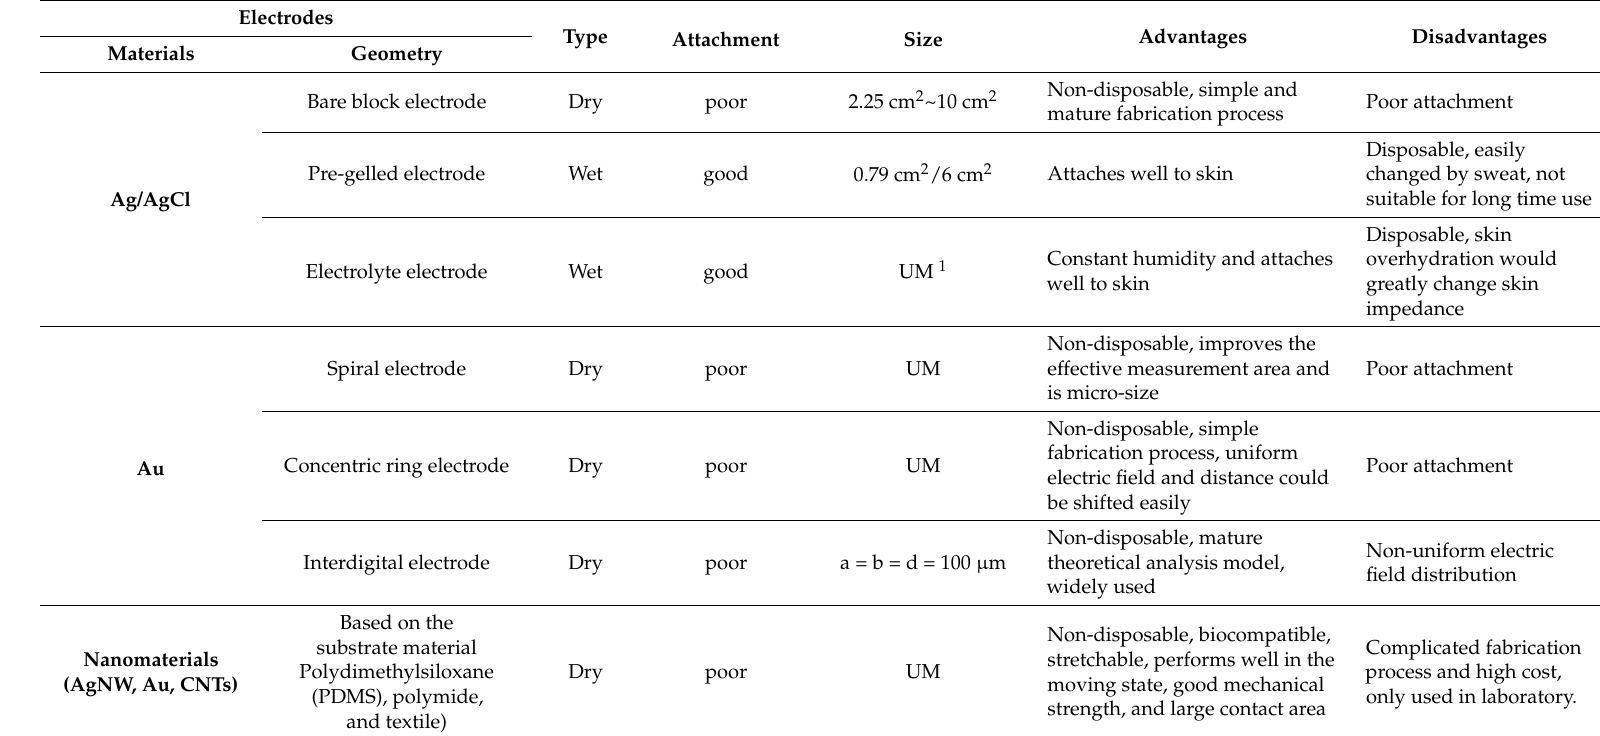
Table 3. Comparison of Characteristics for Different